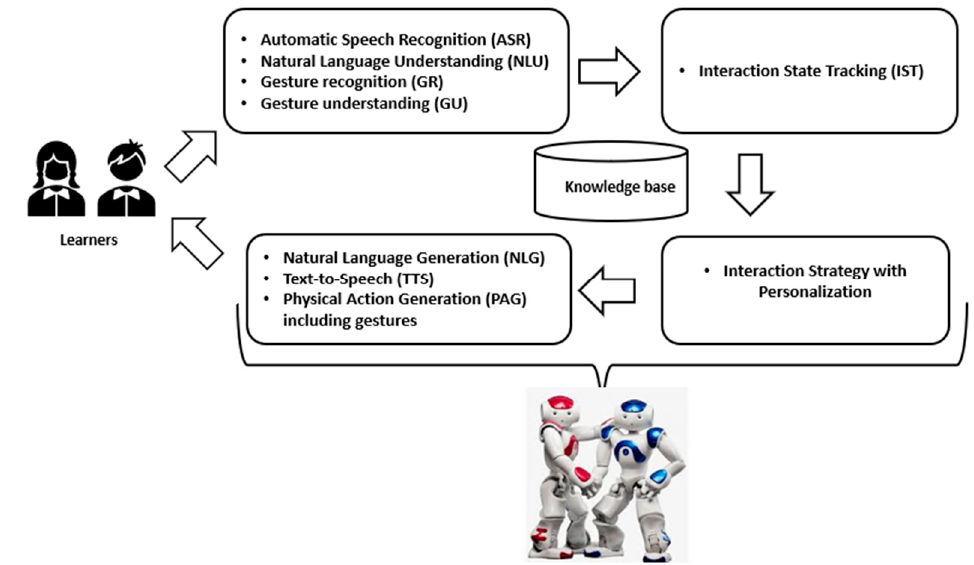
Figure 2. Proposed implementation of spoken dialog system (SDS) in SLEs.